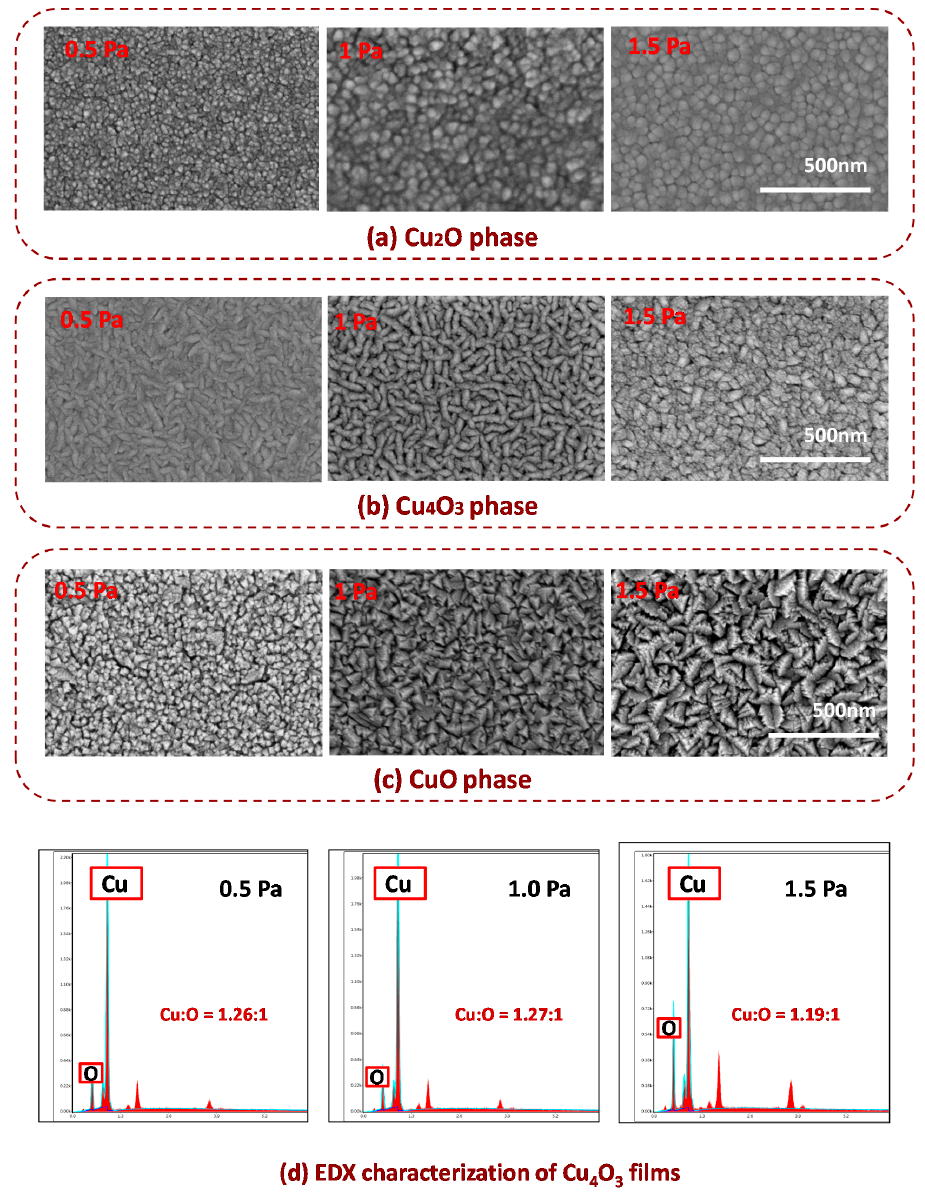
Figure 3. SEM images for the morphology evolution of the deposited films under various total pressures for ( a ) Cu 2 O; ( b ) Cu 4 O 3 , and ( c ) CuO; ( d ) the EDX characterization of Cu 4 O 3 films deposited under 0.5 Pa, 1.0 Pa, and 1.5 Pa, respectively.